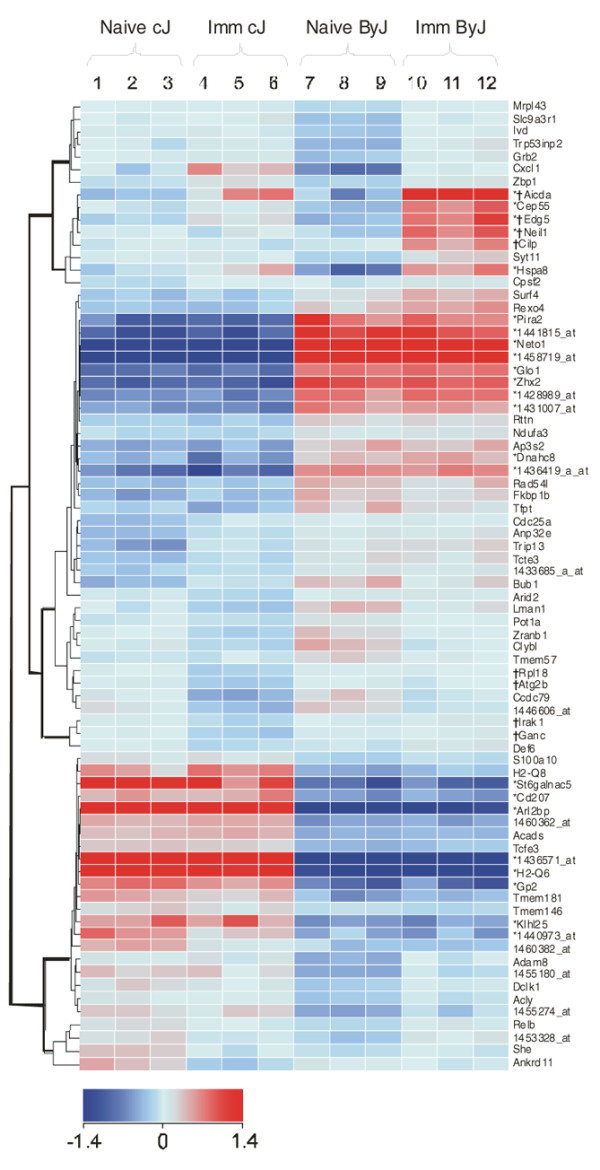
Hierarchical clusterization comparing the 77 genes expressed differently at significant levels in spleen cells of naive and proteoglycan-immunized (not-yet-arthritic) mice of BALB/cJ and BALB/cByJ colonies (n = 3 of each, four-group cross-comparison: naïve BALB/cJ versus immunized BALB/cJ, naïve BALB/cByJ versus immunized BALB/cByJ, naïve BALB/cJ versus naïve BALB/cByJ, and immunized BALB/cJ versus immunized BALB/cByJ). Color code indicates the normalized intensity expression values (with baseline transformation) on a logarithmic scale. Twenty-three genes showing over twofold differences in any of the four comparisons are labeled with asterisks. Whenever a gene name was not identified (n = 14), the original probe set ID (number_at), the Riken ID (numberRik), or the expressed sequence tag clone number is used. Those genes that showed significant differences only in response to immunization (n = 8) are labeled with the '†' symbol. Original data files are available via Gene Expression Omnibus (accession number [GEO:GSE13730] and National Center for Biotechnology Information tracking system number 15549466).